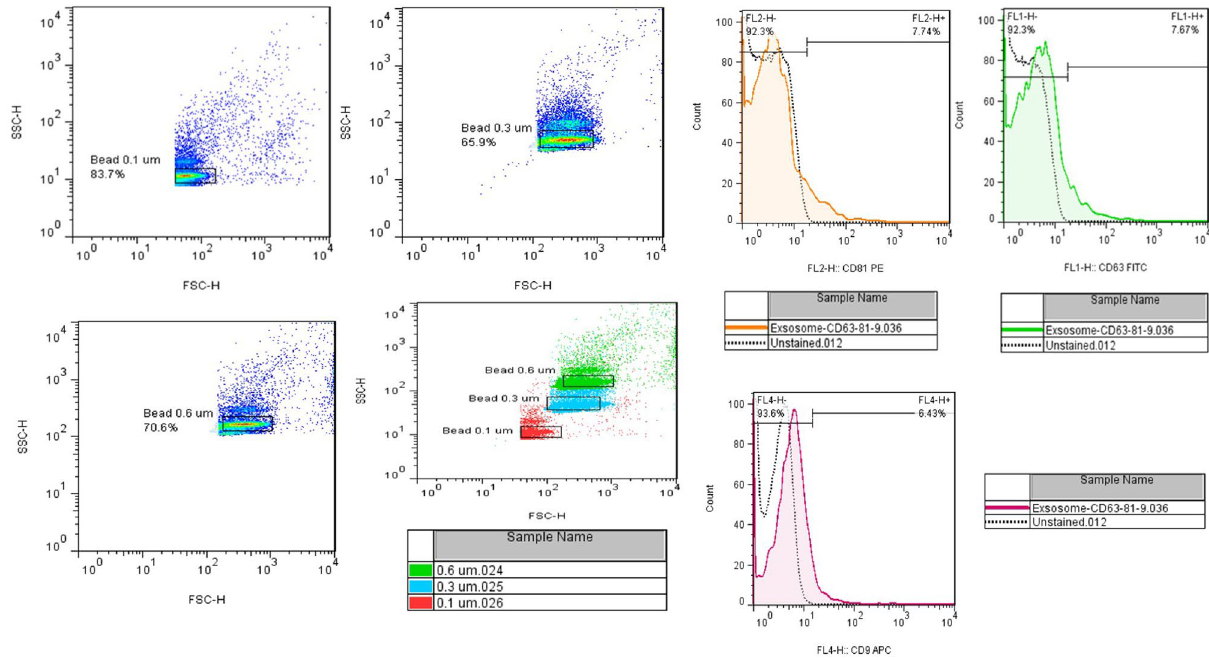
Figure 2. Antibodies used to examine exosomes target CD9, CD63, and CD81